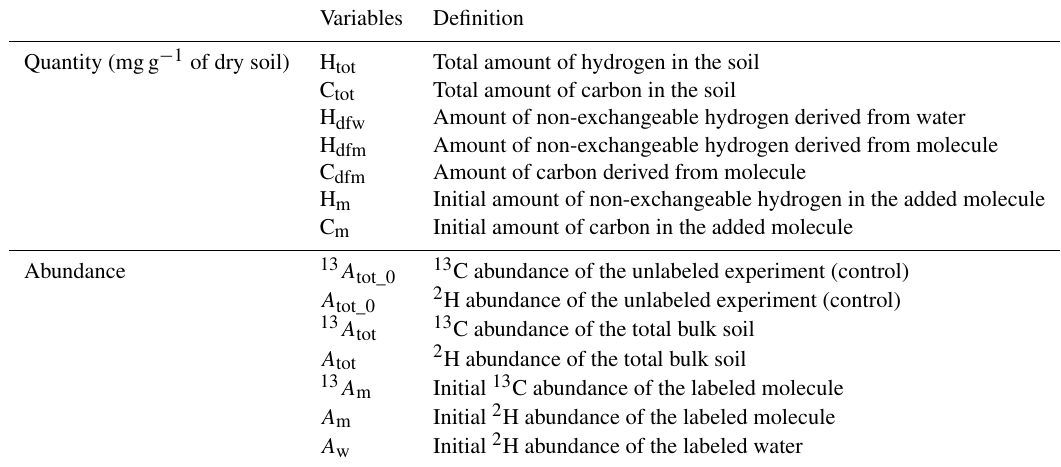
Table 2. Definition of the variable used in calculations.